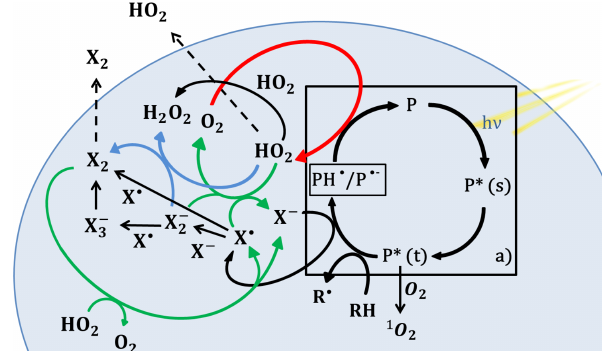
Figure 1. Photochemical catalytic cycle of IC (box “a)”) and halide radical chemistry induced in a particle. IC is a photosensitizer (P) that first absorbs light, excites to its singlet state P ∗ (s) and transi- tions to its triplet state P ∗ (t), which reacts with an H atom/electron (cid:113) donor (RH and X − ) to produce the reduced ketyl radical (PH ) (cid:113) and halide radicals ( X ). The halide radicals can produce molec- (cid:113) ular halogen ( X 2 ) or X − by reacting with X − . PH may transfer a 2 H atom or electron to an acceptor, such as O 2 producing HO 2 rad- icals. HO 2 can recycle the halide radicals previously produced into to produce halogen molecules. halides or further oxidize the X − 2 HO 2 radicals can be released into the gas phase or react within the particle with halide radicals or with itself. Solid lines refer to reac- tions, and dashed lines refer to transfer from the condensed to the gas phase. The red arrow indicates HO 2 production, the green ar- rows indicate recycling of halides promoted by HO 2 and the blue arrows indicate the reaction of X − with HO 2 to form X 2 . Rate co- 2 efficients are provided in Table